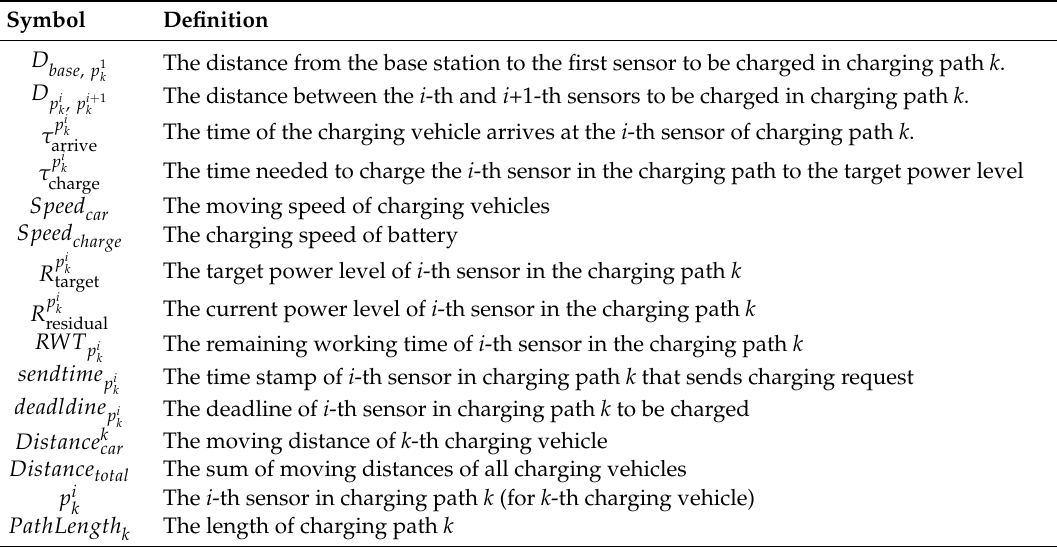
Table 1. Notations used in this